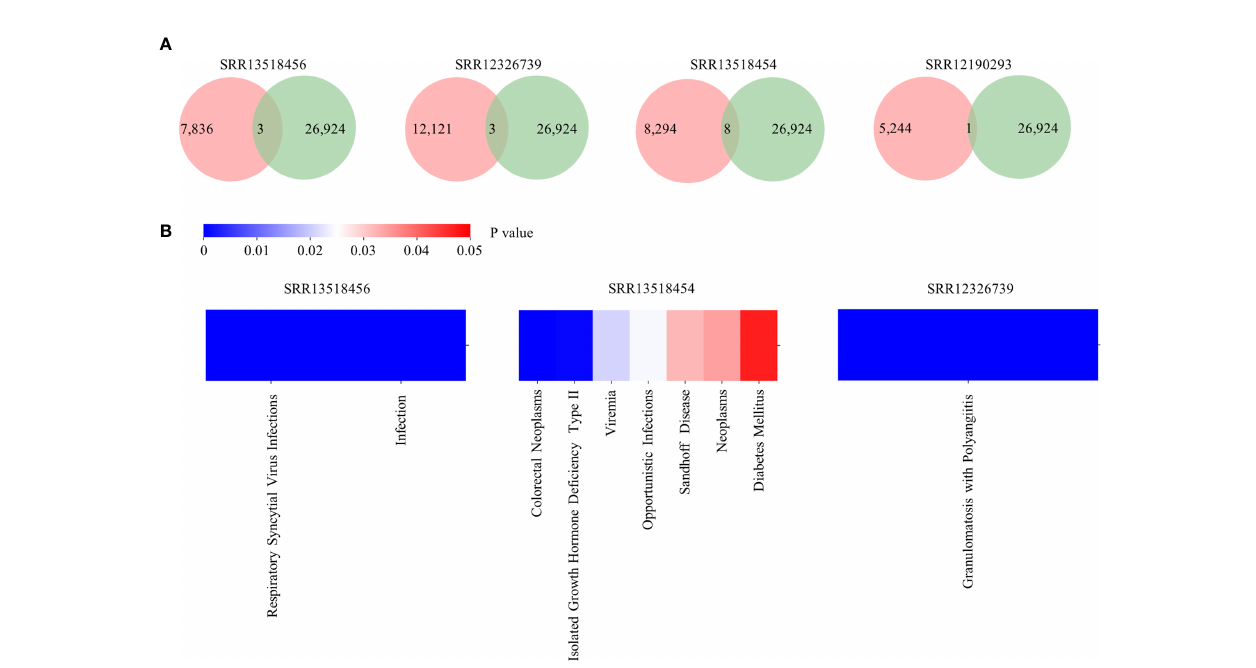
FIGURE 4 | Output of Antibody annotation module. (A) The number of annotated clones for each sample. The pink circle represents the total clone identi fi ed in each sample and the green one indicates the number of heavy chain with detailed annotation in RAPID. (B) The distribution of diseases which are enriched in